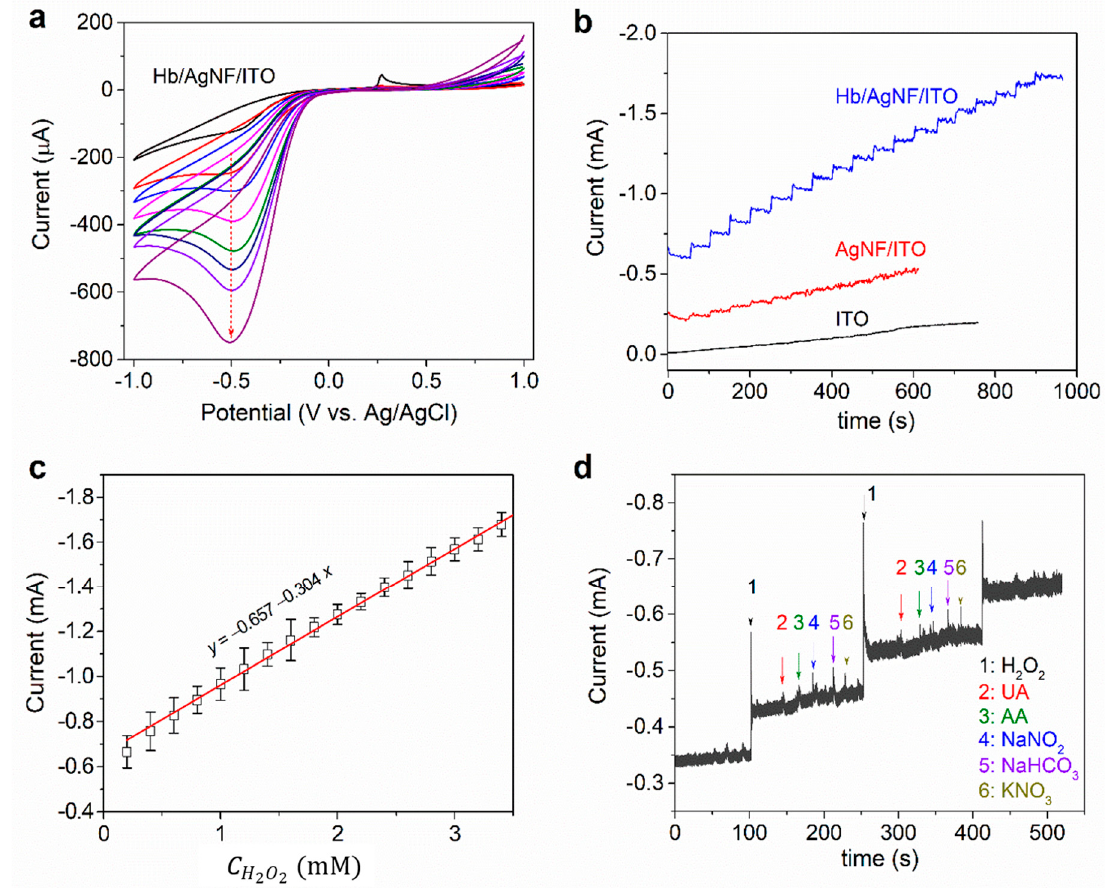
Figure 5. ( a ) Cyclic voltammetry (CV) curves obtained on the Hb / AgNF / ITO electrode upon successive additions of 10 µ L aliquots of 100 mM H 2 O 2 in a 5 mL solution of 10 mM PBS (pH 7.0) at a scan rate of 50 mV / s. The black line of CV presents the blank with no H 2 O 2 . ( b ) Chronoamperometric (CA) curves obtained for bare ITO, AgNF / ITO, and Hb / AgNF / ITO electrodes upon successive additions of 10 µ L aliquots of 100 mM H 2 O 2 to 5 mL of 10 mM PBS with constant stirring (1200 rpm) at an applied potential of − 0.5 V vs. Ag / AgCl under nitrogen purging. ( c ) Calibration curve showing the concentration of H 2 O 2 plotted vs. the measured catalytic peak current; data points express mean ± SD of three replicated measurements, and the fitted curve represents a linear fit equation. ( d ) I - t curves obtained from a Hb / AgNF / ITO electrode at − 0.5 V upon successive additions to 5 mL PBS bu ff er (pH 7.0) of 5 µ L aliquots of 0.2 mM uric acid (UA), L-ascorbic acid (AA), sodium nitrite (NaNO 2 ), sodium bicarbonate (NaHCO 3 ), and potassium nitrate (KNO 3 ), along with 5 µ L of 0.2 mM H 2 O 2 , with constant stirring.